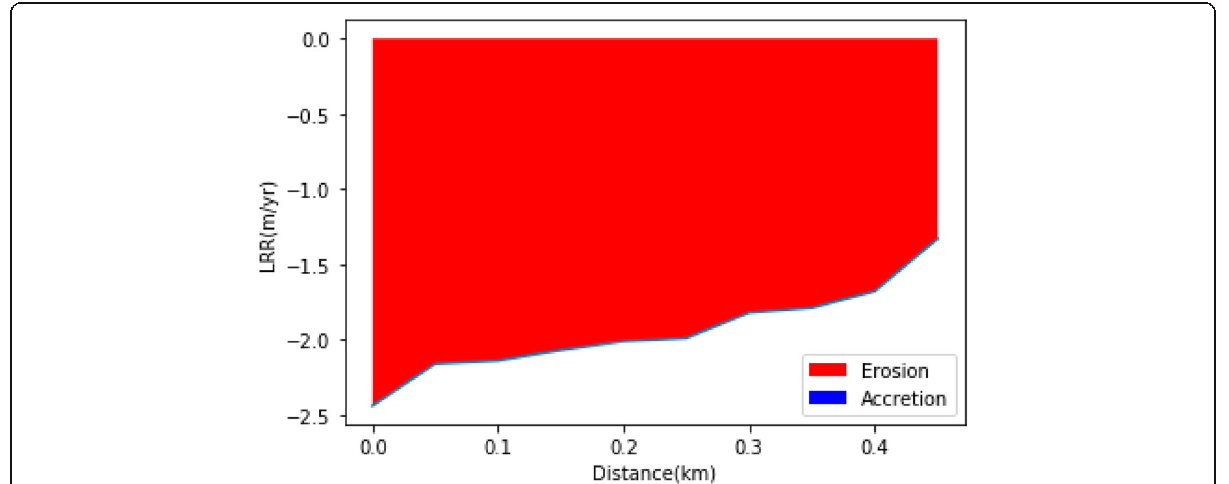
Fig. 9 Shoreline change for the eastern estuarine of the Volta